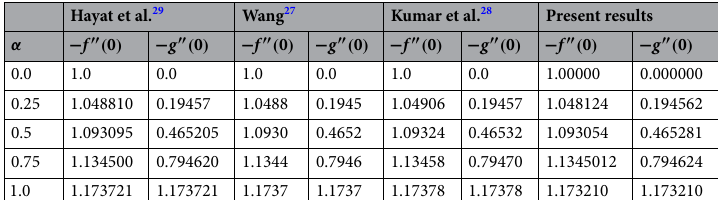
Table 2. Comparative analysis of dimensionless stress by fluctuating the values of velocity rates parameter and setting M = 0.